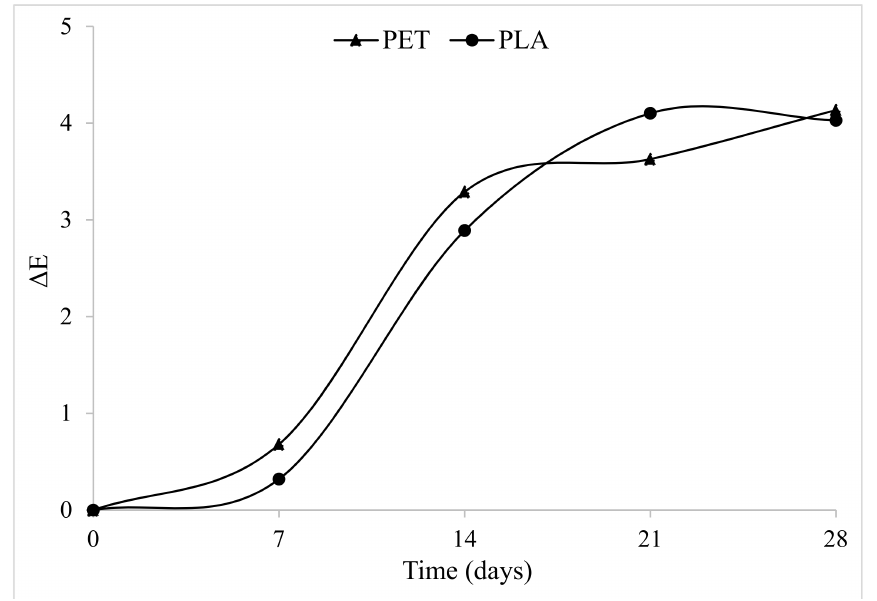
Figure 3. Overall color variation ( ∆ E) of apple juice during refrigerated storage at 6 ◦ C in PLA and PET